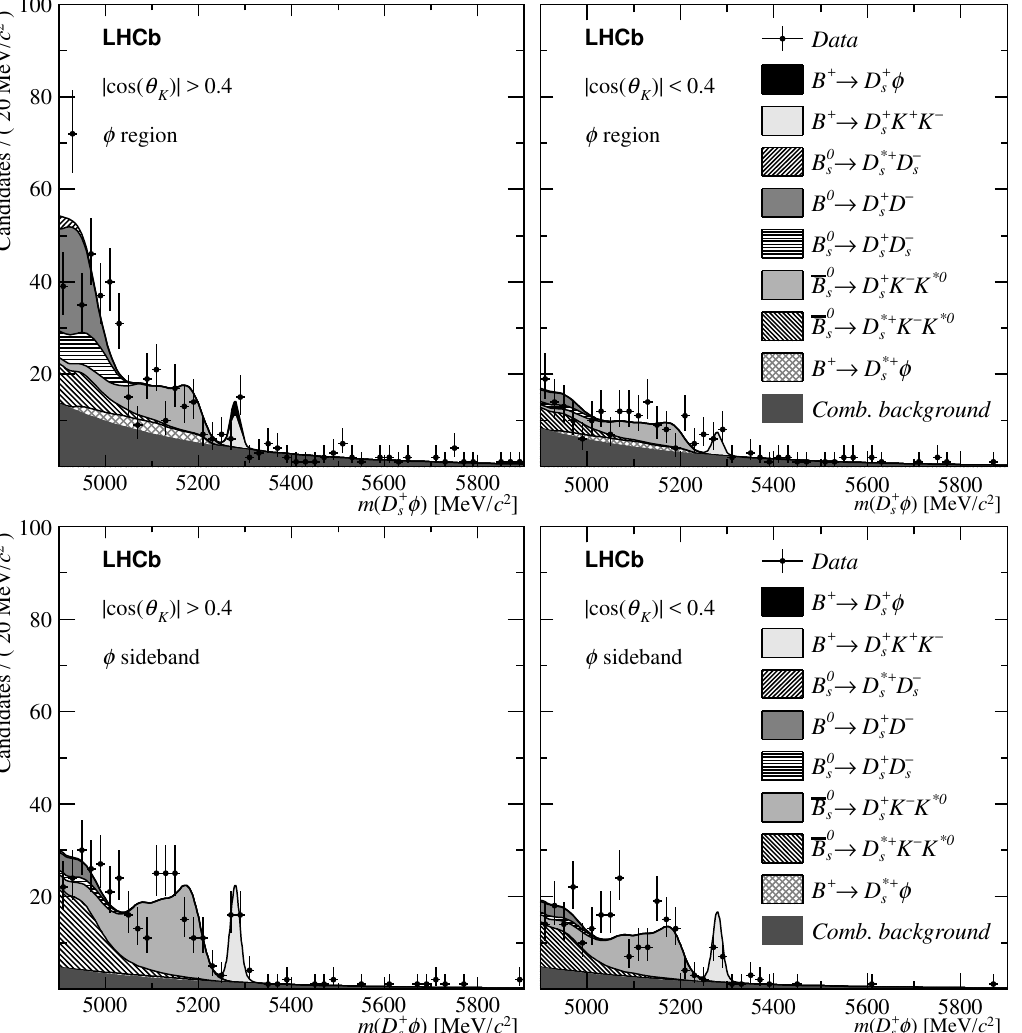
Figure 4. Mass distribution of B + ! D + (cid:30) candidates in (top) the (cid:30) mass region, and (bottom) s the (cid:30) mass sideband. The plots on the left are in the helicity bin j cos (cid:18) K j > 0 : 4 and the right are in j cos (cid:18) K j < 0 : 4. The result of the (cid:12)t to the data using the model described in section 4.1 is overlaid, with the PDF components given in the legend. The B + ! D + (cid:30) decays (black) are expected to s primarily contribute to the (cid:30) region with j cos (cid:18) K j > 0 :